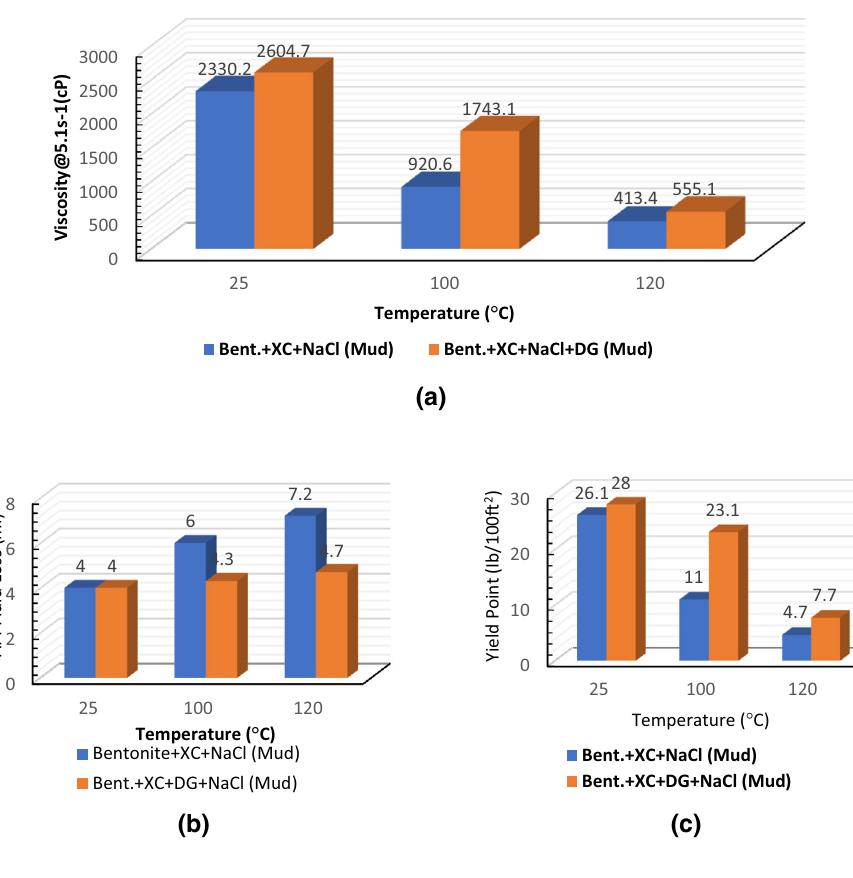
Fig. 14 Comparison of the properties of drilling muds containing a salt after aging at 25 °C, 100 °C, and 120 °C: a low shear rate viscosities of the drilling muds; b API fluid losses of the drilling muds; c yield points of the drilling